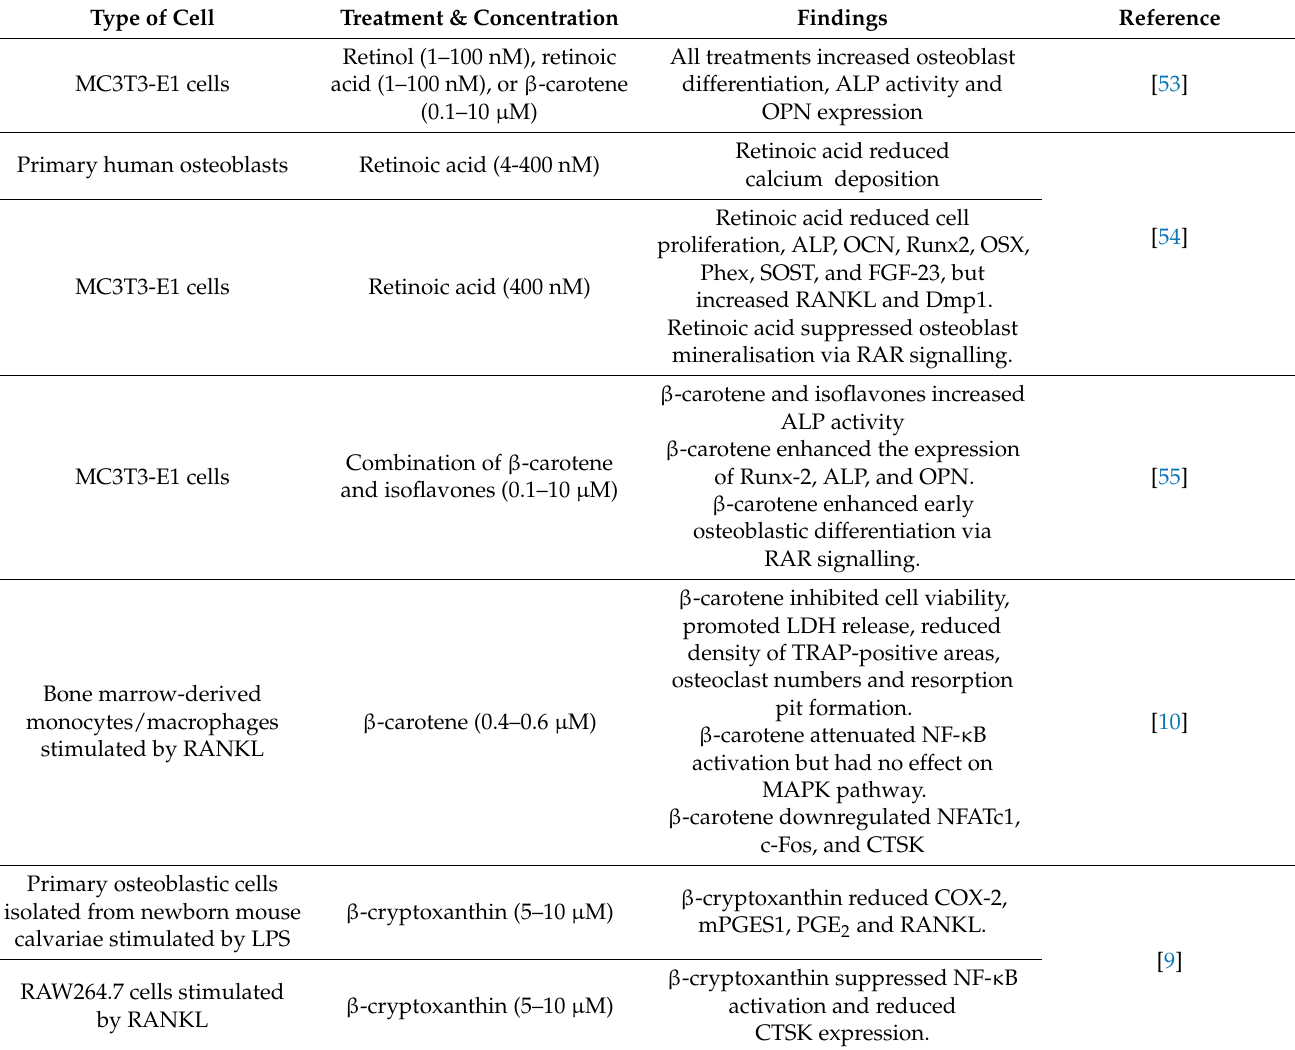
Table 3. Summary on the effects of vitamin A and provitamin A on bone